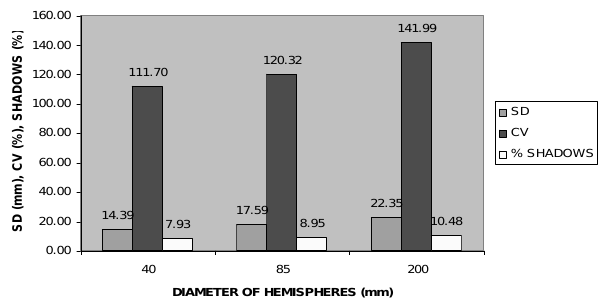
Fig. 7. Shadows analysis and statistical indexes for laboratory tests including CV, coefficient of variation, and SD, standard deviation, for percentage of shadows as a function of the diameter of the hemi-